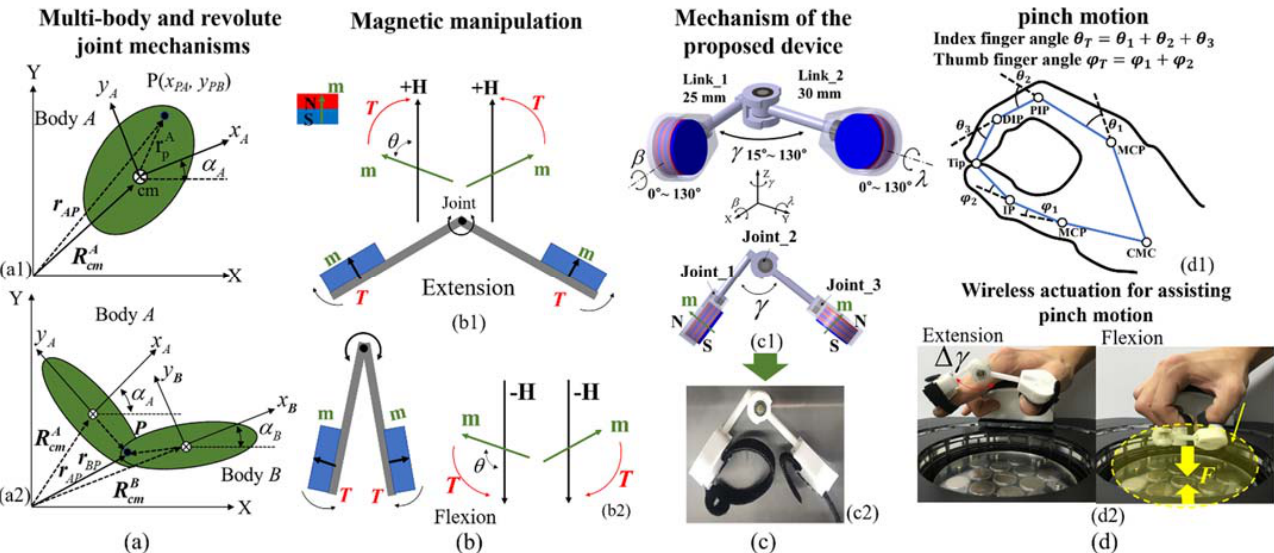
Figure 1. Principles involved in wireless finger rehabilitation: ( a ) free body diagram (FBD) of multibody and revolute joint mechanisms; ( b ) magnetic actuation method using the multibody mechanism for pinching motions (extension and flexion); ( c ) configuration and mechanism of the proposed device; ( d ) pinch motion with fingertip positions and actual pinching movement using the developed device.